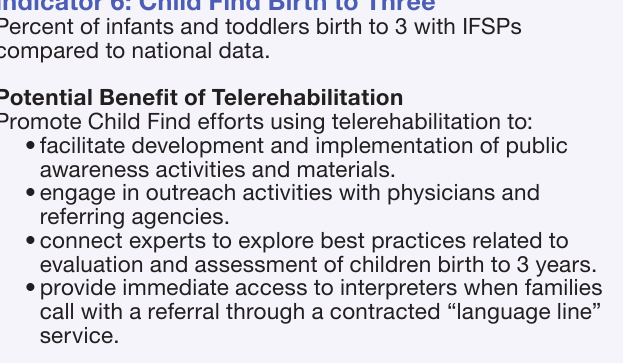
Indicator 5: Child Find Birth to One Percent of infants and toddlers birth to one with IFSPs compared to national data. Indicator 6: Child Find Birth to Three Percent of infants and toddlers birth to 3 with IFSPs compared to national